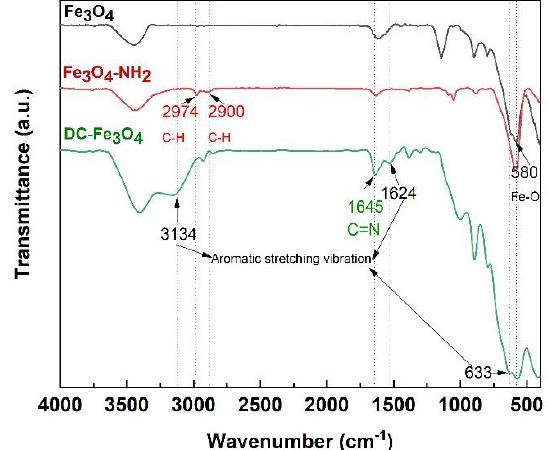
Figure 2. FTIR spectra of Fe 3 O 4 , Fe 3 O 4 -NH 2 , and DC-Fe 3 O 4 nanoparticles.